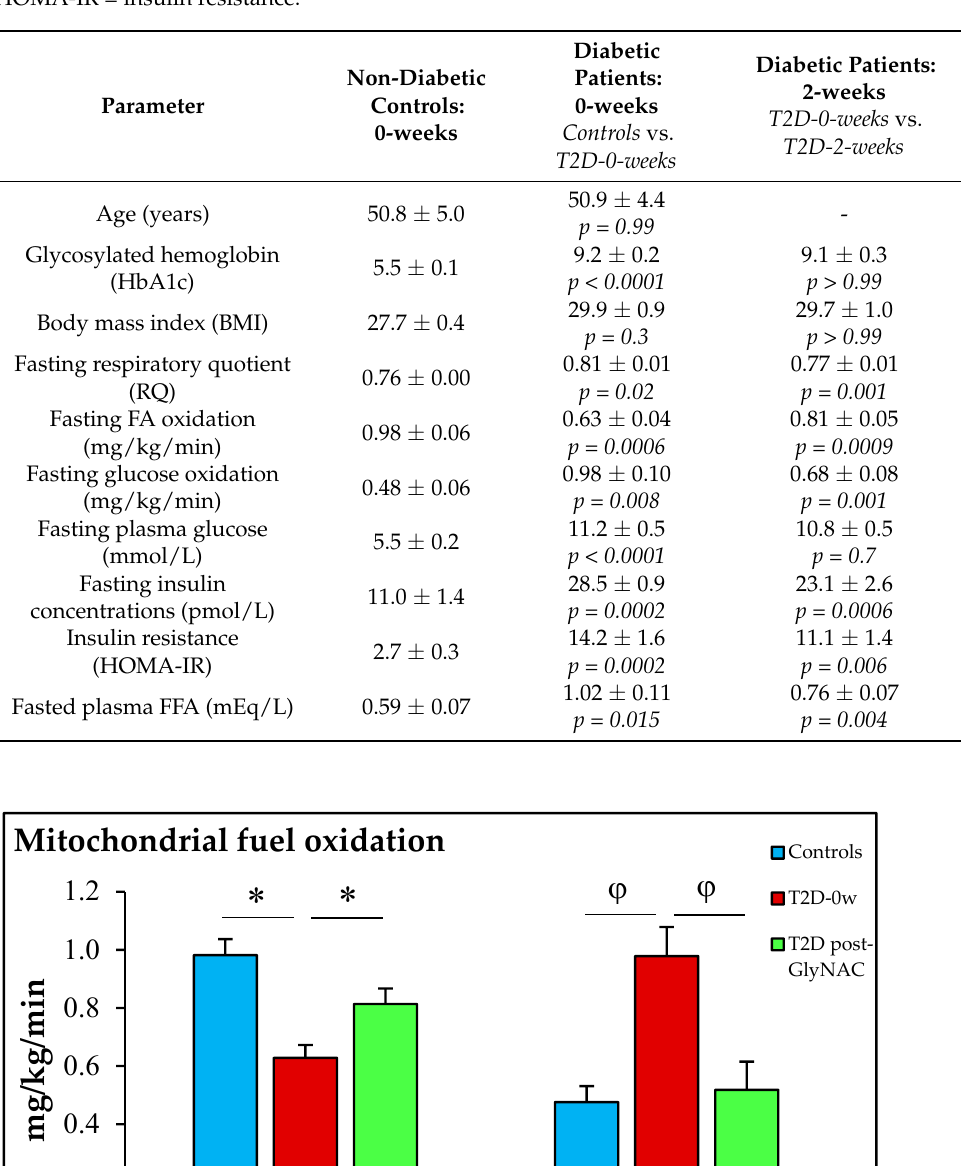
Table 1. Fasted fuel oxidation, glycemic indices and FFA concentrations. Values are means ± SE; Means are significantly different at p < 0.05. T2D = type 2 diabetes; 0-weeks = baseline study; 2-weeks = study conducted after 2-weeks of GlyNAC supplementation; FFA = free-fatty-acids, HOMA-IR = insulin resistance.